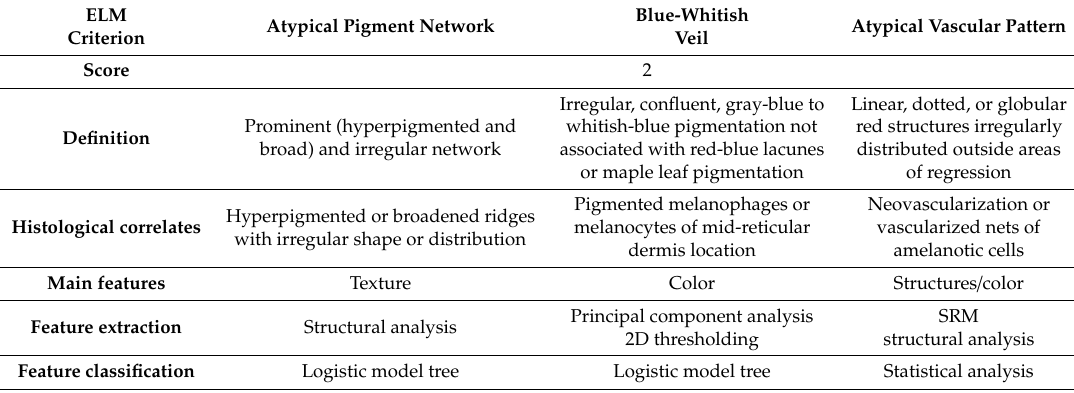
Table 1. The automatic system based on Seven-Point Checklist: Definition and detection methods of major dermoscopic